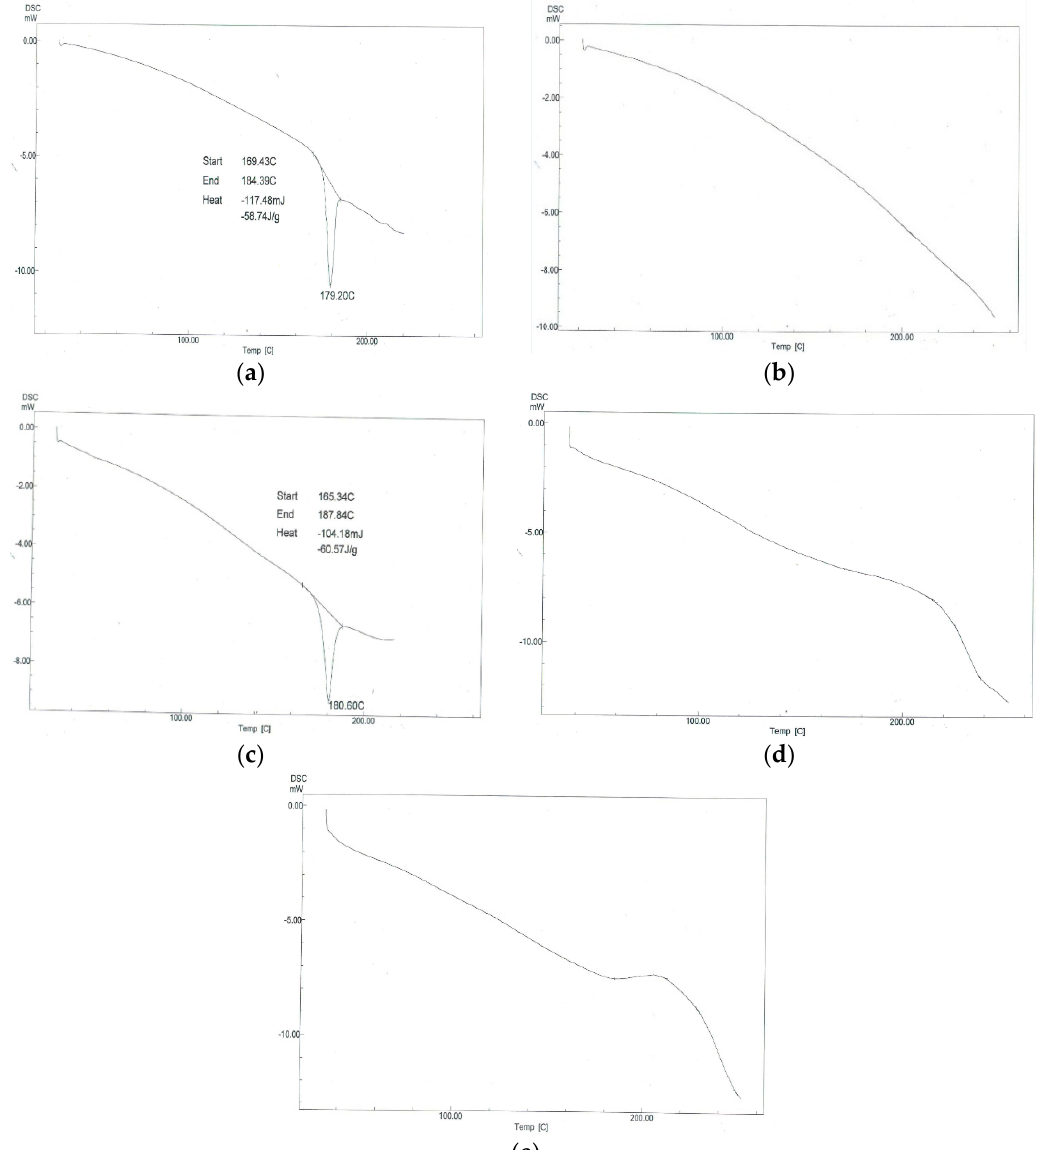
Figure 8. DSC thermograms of ( a ) pure OLM; ( b ) Aerosil 200; ( c ) physical mixture of OLM and Aerosil 200; ( d ) OLM S-SNEDDS formula (F3); ( e ) OLM S-SNEDDS formula (F4).